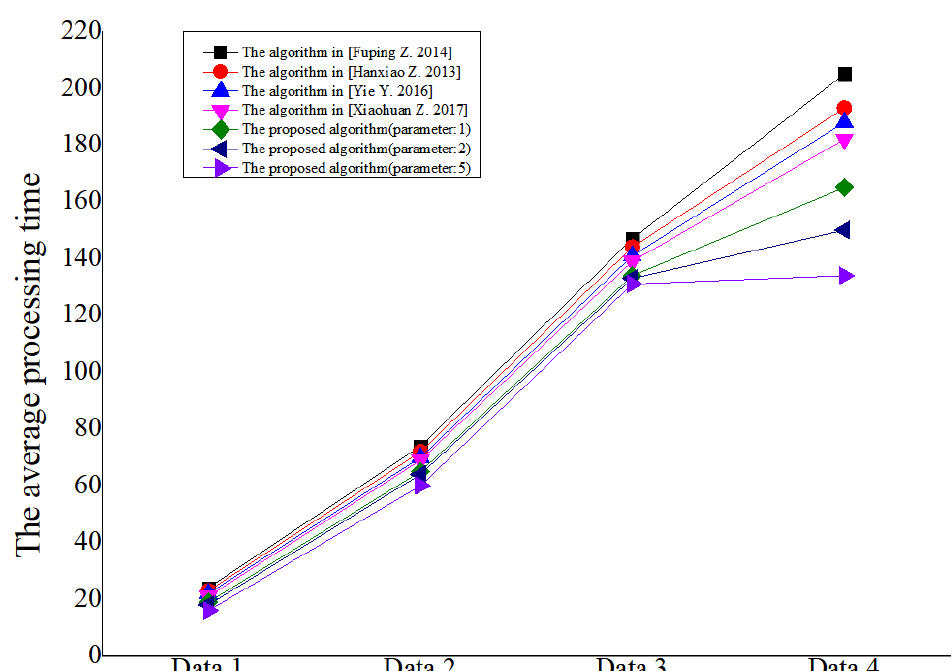
Figure 14. Comparison between the proposed algorithm and Ref. [18].